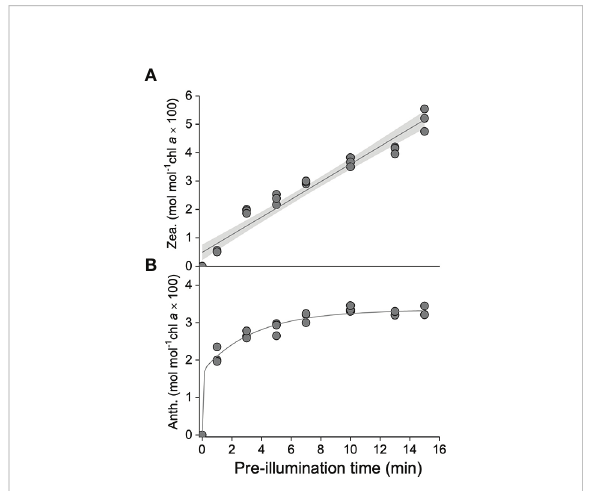
FIGURE 4 Concentrations of (A) zeaxanthin (Zea., mol mol – 1 Chl a × 100) and (B) antheraxanthin (Anth., mol mol – 1 Chl a × 100) during the pre-illumination time (1200 m mol photons m – 2 s – 1 ). The solid line and gray shadow in A represent the fi t of data to a linear model ( p < 0.01 and R 2 = 0.99; n = 24) and the 95% con fi dence interval, respectively. The solid line in B represents the fi t of data to an exponential model ( p < 0.01 and R 2 = 0.99, n = 24).